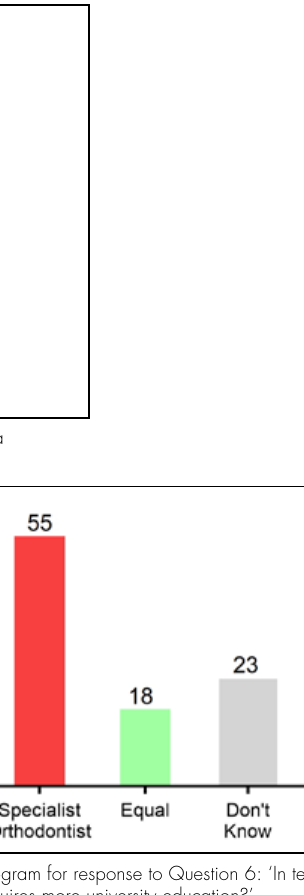
Previous treatment performed by dentist